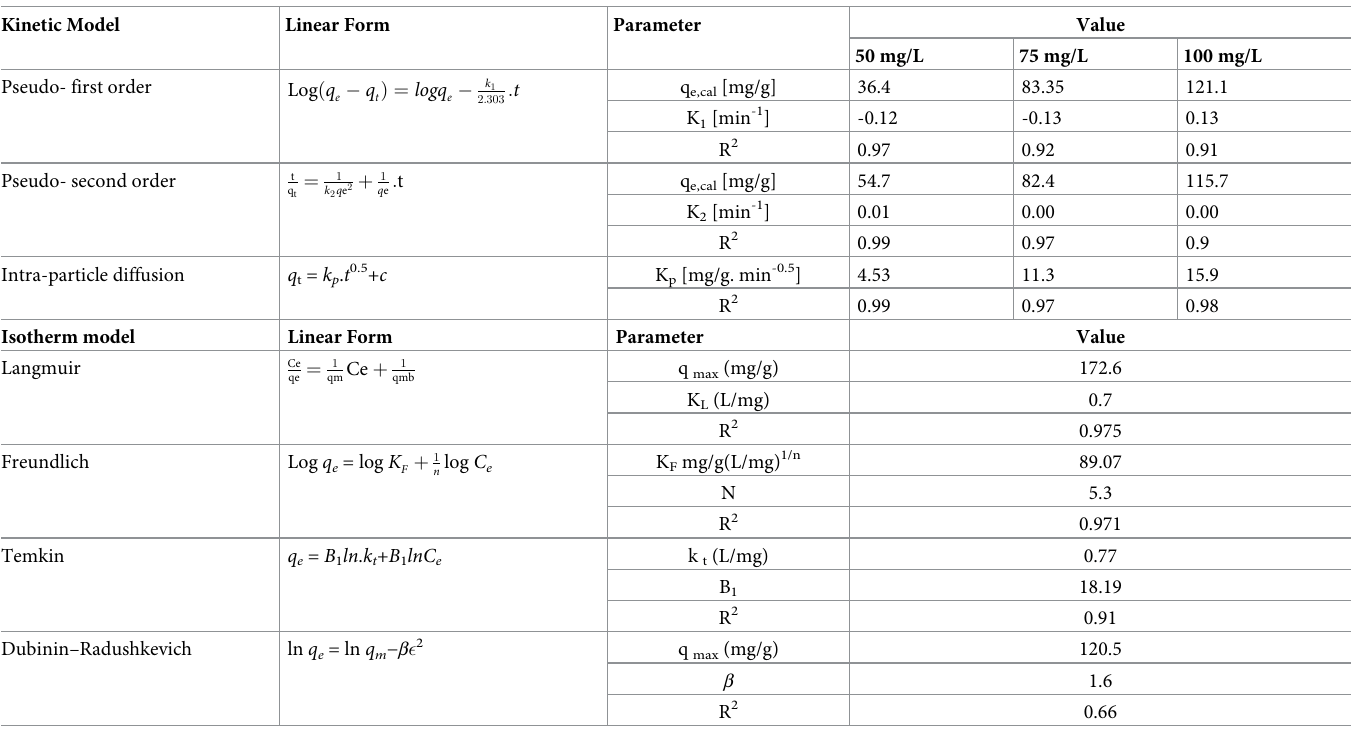
Table 8. The kinetic and isotherm parameters fitted for CIP adsorption [40]. Kinetic